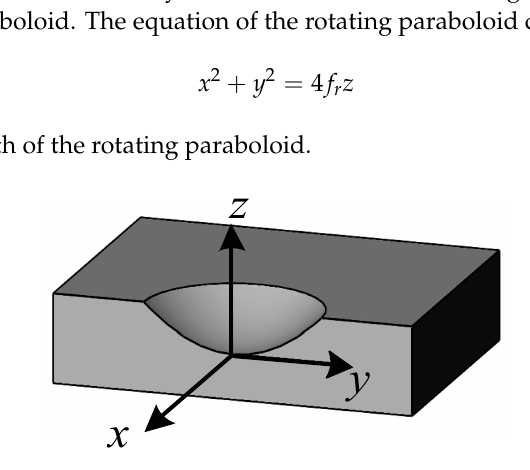
Figure 1. Three-dimensional model of rotating paraboloid.